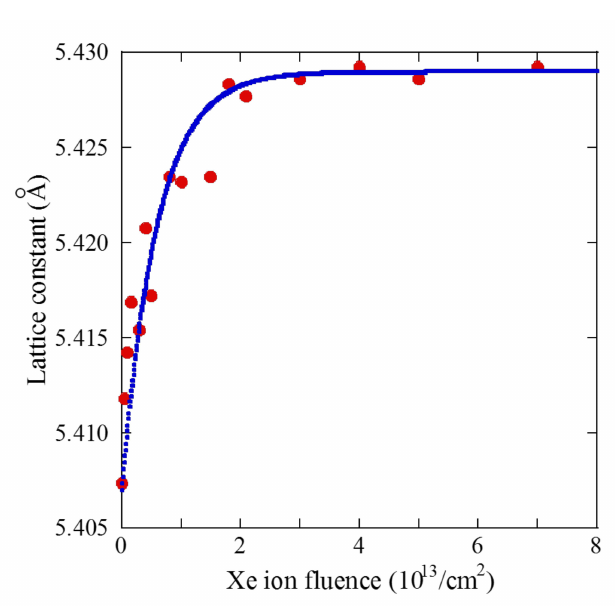
Figure 7. Curve fitting of the Xe ion fluence dependence of lattice constant of CeO 2 by using the Poisson law. Solid circles are experimental results and the solid line is the fitting curve.